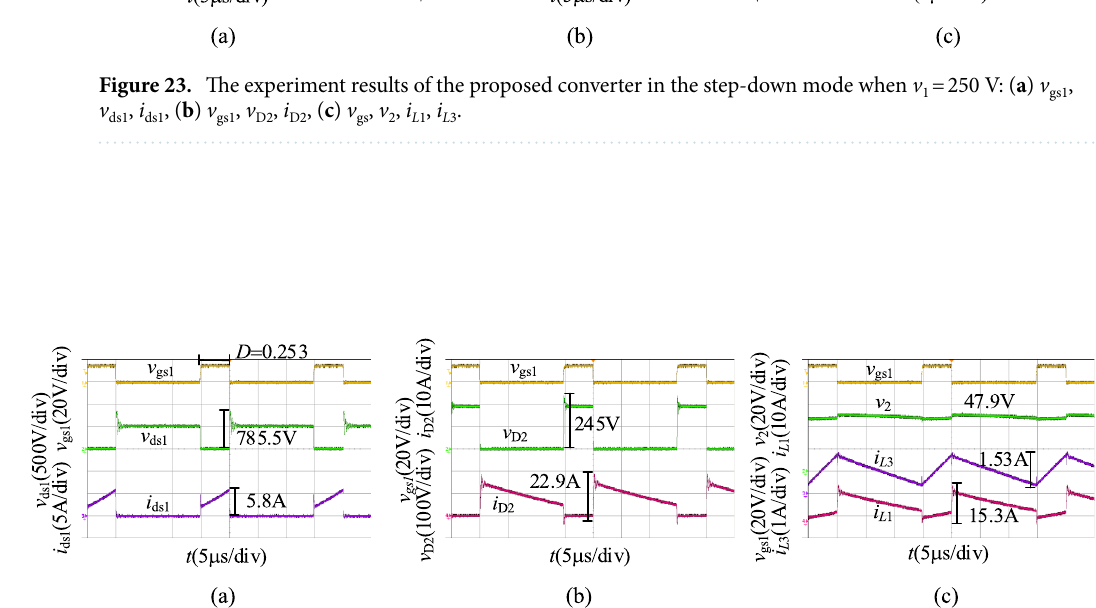
Figure 24. The experiment results of the proposed converter in the step-down mode when v 1 = 430 V: ( a ) v gs1 ,